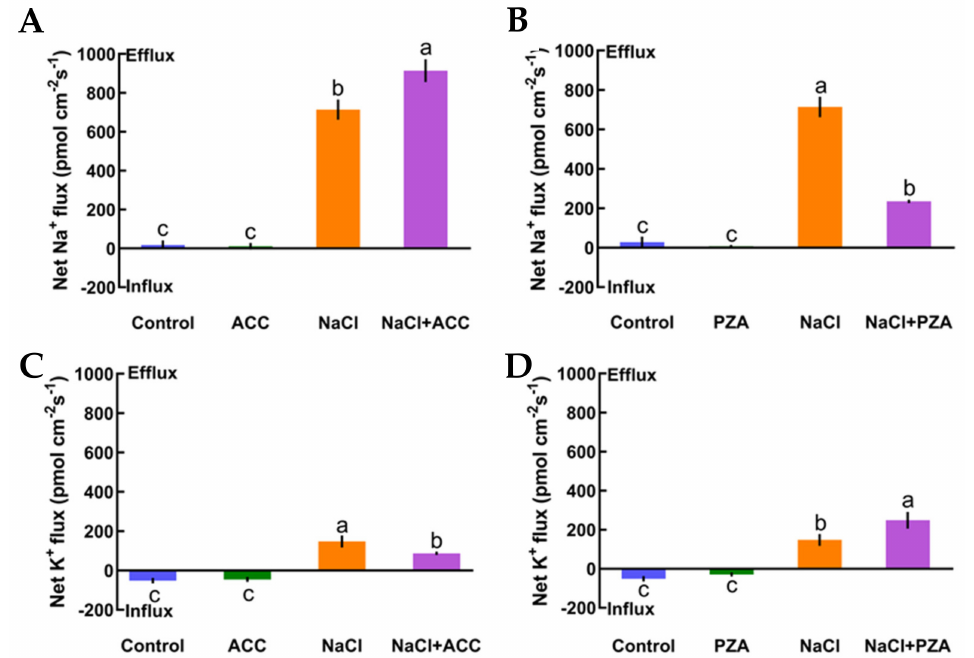
Figure 4. E ff ects of 1-aminocyclopropanecarboxylic acid (ACC, 10 µ M) and pyrazinamide (PZA, 100 µ M) on the steady-state Na + and K + flux kinetics of Col-0 roots under short-term NaCl stress (100 mM, 12 h). Roots cultured in MS medium were untreated or subjected to short-term NaCl stress (100 mM, 12 h) in the absence or presence of ACC (10 µ M). For the pharmacological inhibitor experiments, MS-cultured roots were untreated or stressed by NaCl for 12 h, then subjected to PZA (100 µ M) for 30 min prior to measurement of flux kinetics. Salt-elicited Na + ( A , B ) and K + ( C , D ) flux kinetics were recorded at the meristem root zones (500 µ m from the root apex) in the